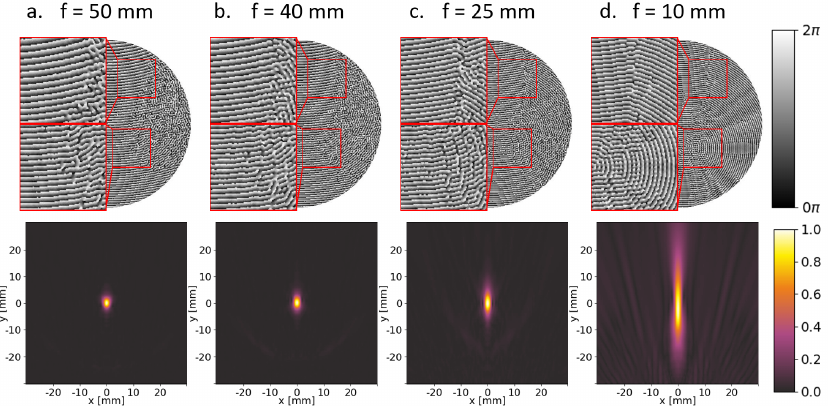
Figure 7. The comparison of phase distributions ( top panels) and calculated focal spots ( bottom panels) of the off-axis lenses with varying focal lengths: ( a ). f = 50 mm, ( b ). f = 40 mm, ( c ). f = 25 mm and ( d ). f = 10 mm. The same two parts of all lenses have been magnified to make fine changes in the phase maps more